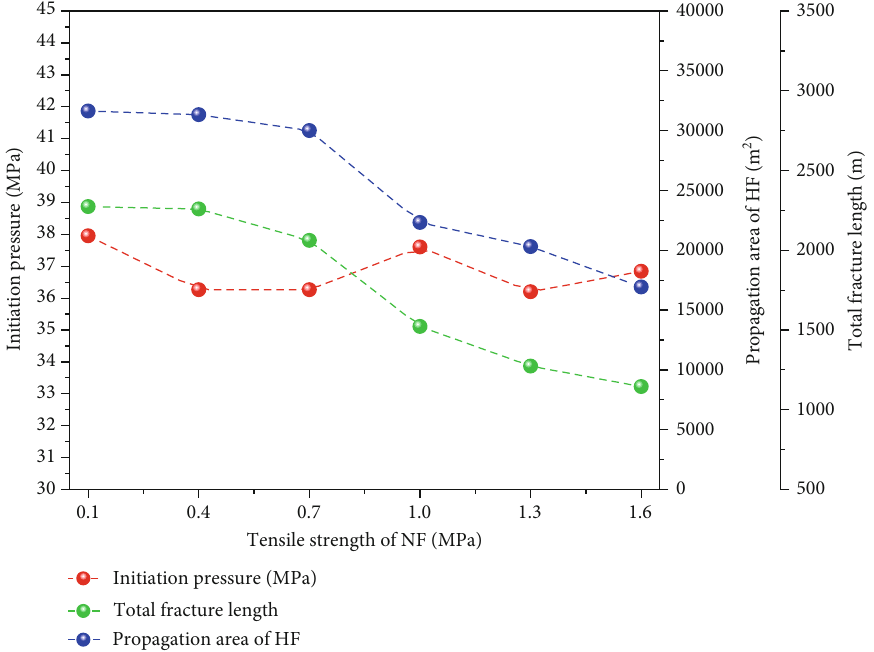
Figure 14: Total equivalent hydraulic fracture length and propagation area of the complex fracture